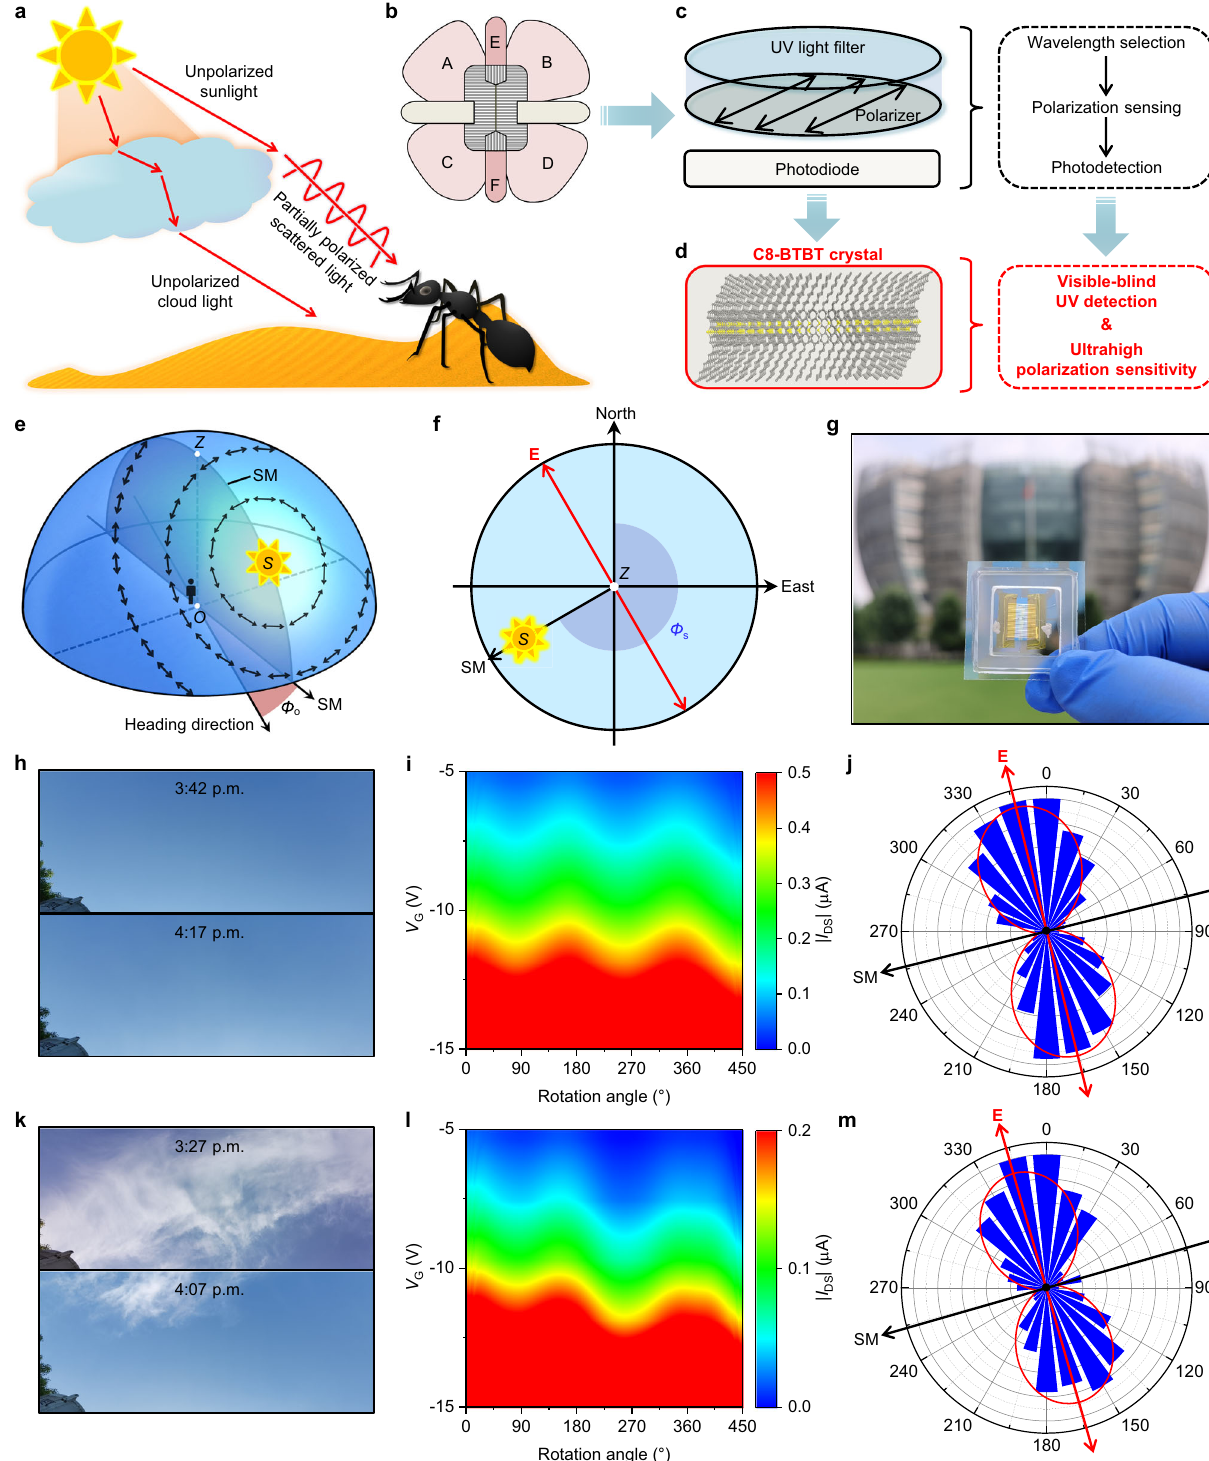
Fig. 4 | Bionic polarization navigation implemented by C8-BTBT-based pho- totransistors. a Schematic illustration of the polarization of skylight. b Cross- sectional sketch of the dorsal rim ommatidia of Cataglyphis . c Schematic illustra- tion of a conventional polarization navigation sensor, which is composed of spa- tically separated light fi lter, polarizer, and photodiode. d Schematic illustration of the ordered molecular packing of C8-BTBT crystal, which combines visible-blind UV detection with ultrahigh polarization sensitivity in a single component. e Schematicillustrationoftheidealskylightpolarizationmodewiththedirectionof E marked by black arrows. The O , Z , and S points represent the positions of observer, zenith, and the sun, respectively. f 2D projection of the skylight